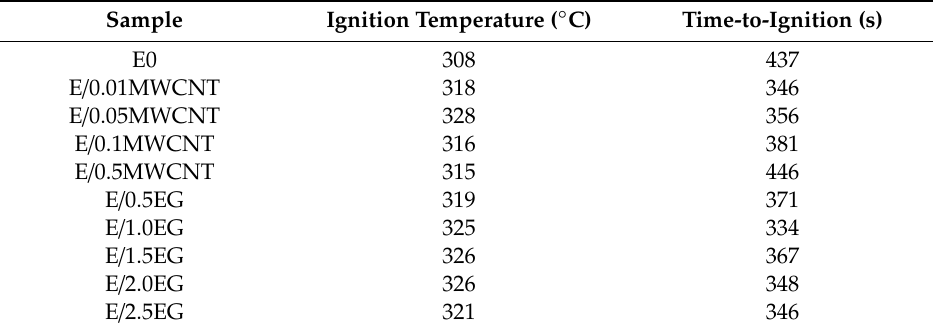
Table 4. Ignition temperature and